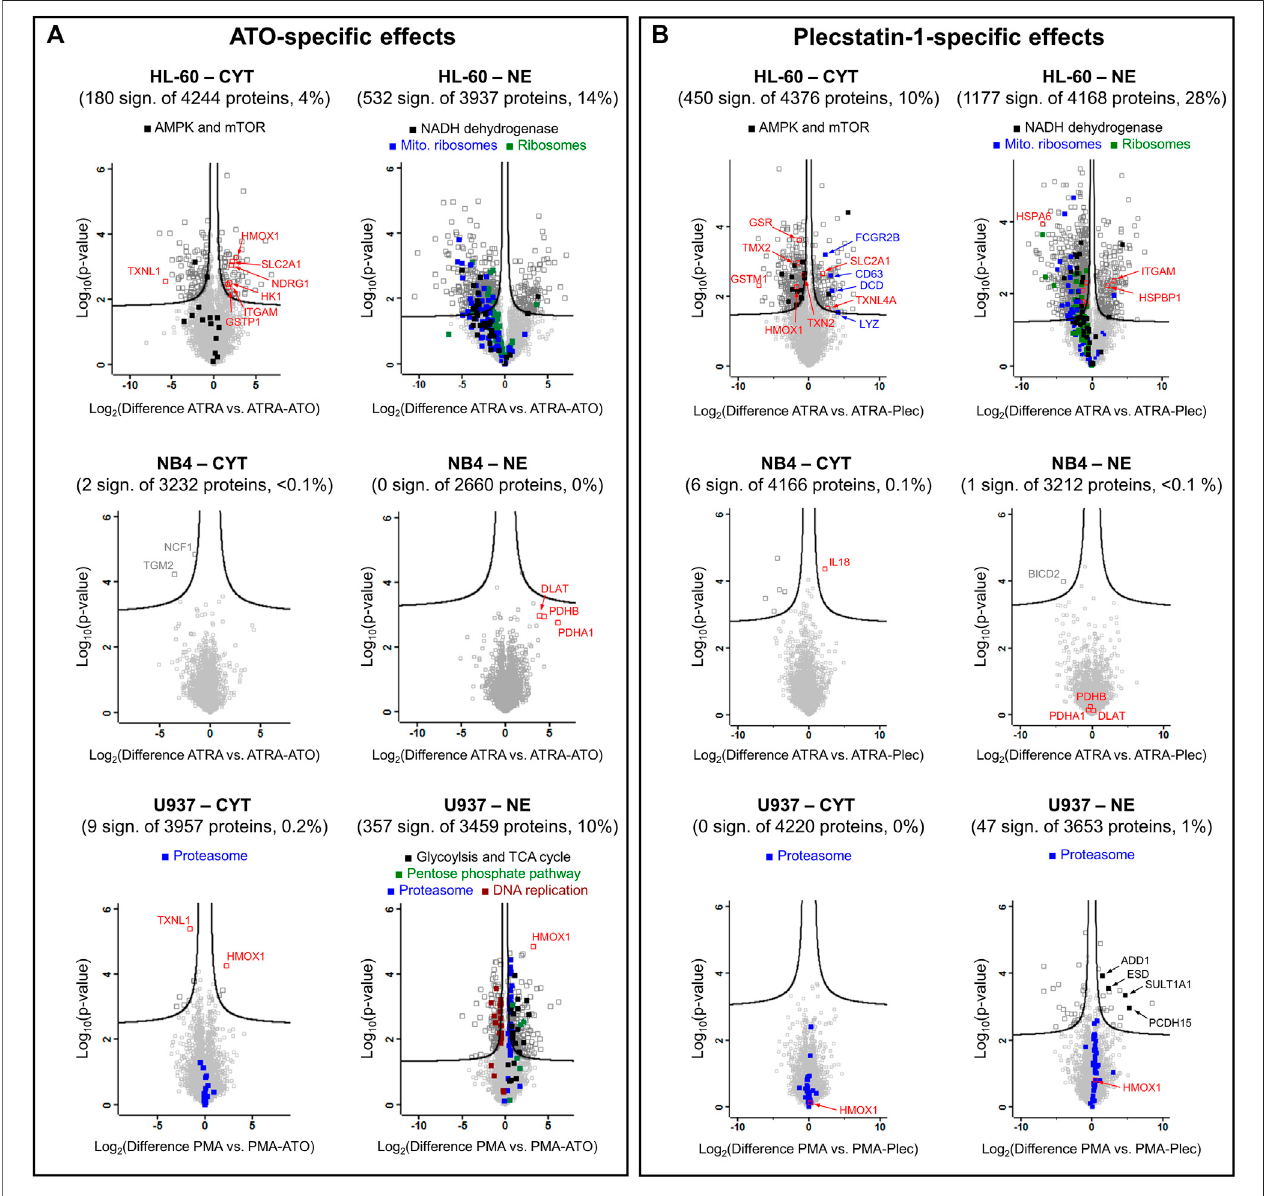
FIGURE 4 | Volcano plots of HL-60, NB4 and U937 cancer cell linestreated with (A) ATO + ATRA (PMA) or (B) plecstatin-1+ATRA (PMA) over 48 h in comparison to differentiation with ATRA (PMA) alone. The Log 2 (differences) refer to logarithmised differences of LFQ intensity of a given protein between the two conditions. Multi- parameter corrected signi fi cances were calculated with Perseus (Version 1.6.6.) using an FDR (cid:1) 0.05 and S0 (cid:1) 0.1. Proteins are represented by squares. Signi fi cantly regulated proteins are given in dark grey, non-regulated proteins in light grey.